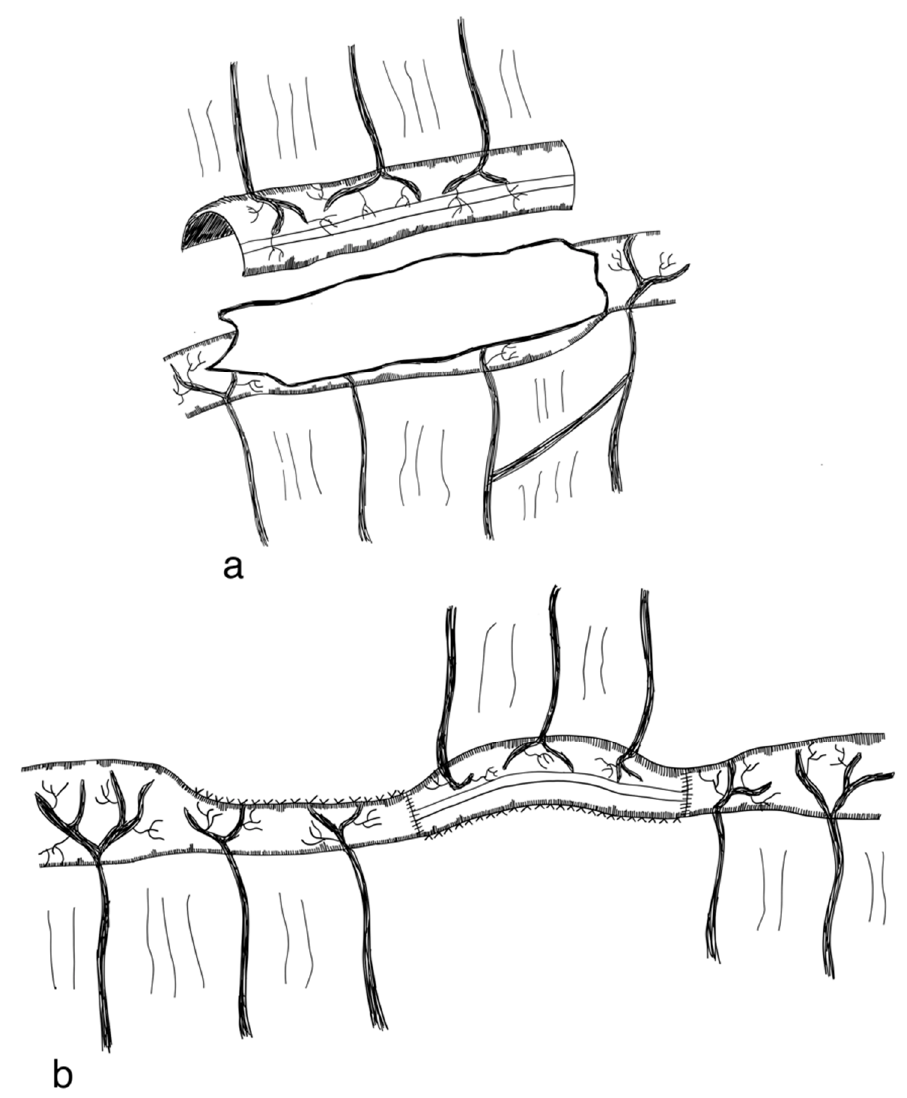
Figure 9. ( a ) Isolation of 30 cm colon segment, longitudinal cut along the antimesenteric border, and removal of colon mucosa. A 30 cm ileum segment was cut along the antimesenteric border. Isolated demucosed colon was then sutured to the exposed ileal submucosa. ( b ) Then, 8–10 weeks later, the modified 30 cm ileo-colic loop was cut in two halves, tubularized and anastomosed isoperistaltically to the remaining small intestine. Bianchi et al. [134].